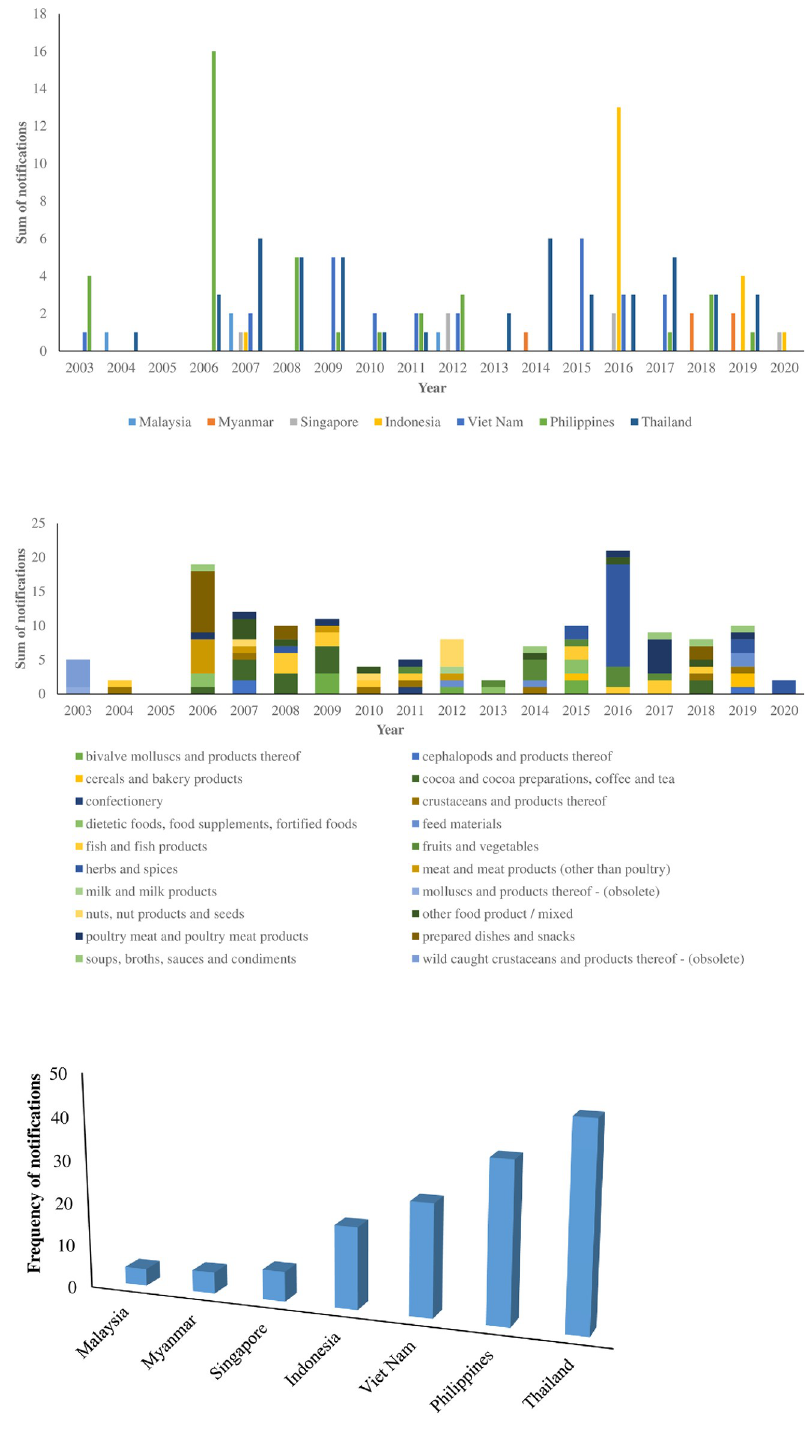
Fig 3. a. Distribution of food fraud notifications in RASFF by year in ASEAN countries (2000 and 2020). b. Distribution of food fraud notifications in RASFF by product category in ASEA countries (2000 and 2020). c. Number of food fraud notifications in RASFF by country (2000 and